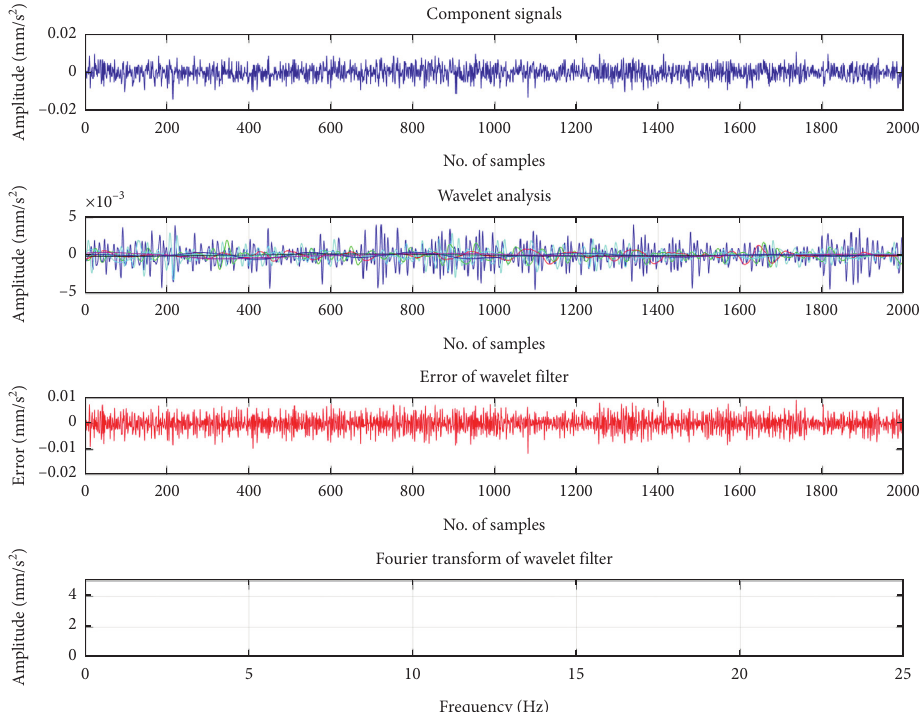
Figure 6: The amount of noise signal during measurement.